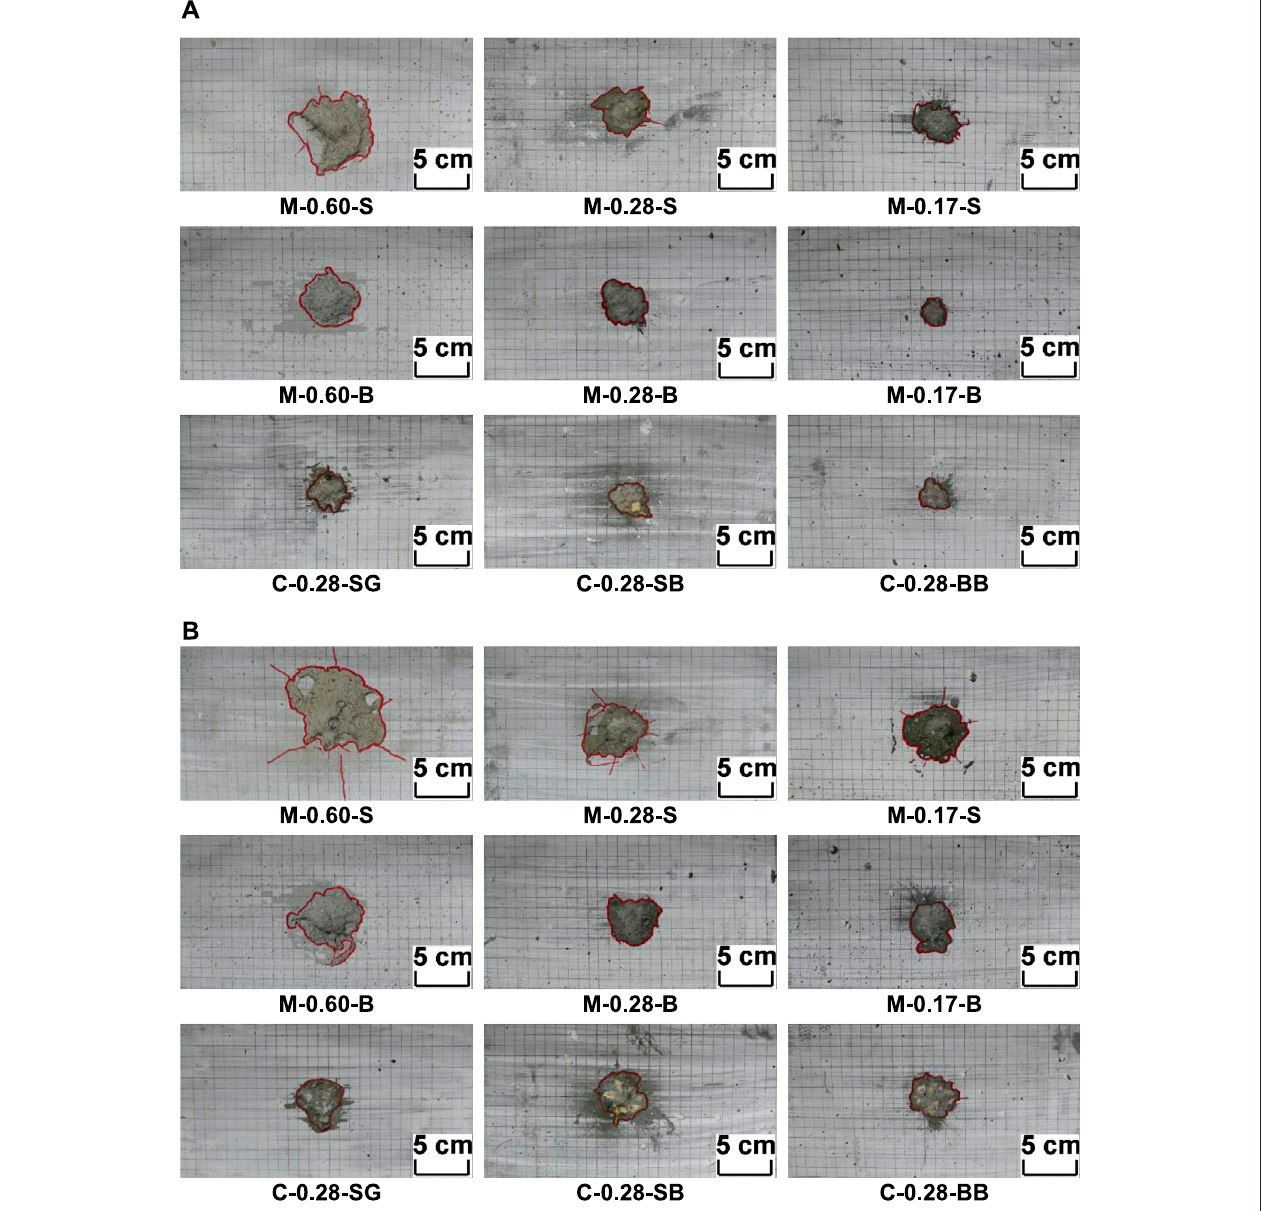
FIGURE 5 | Damage of cement composites after impact tests (A) deformable projectile and (B) non-deformable projectile.